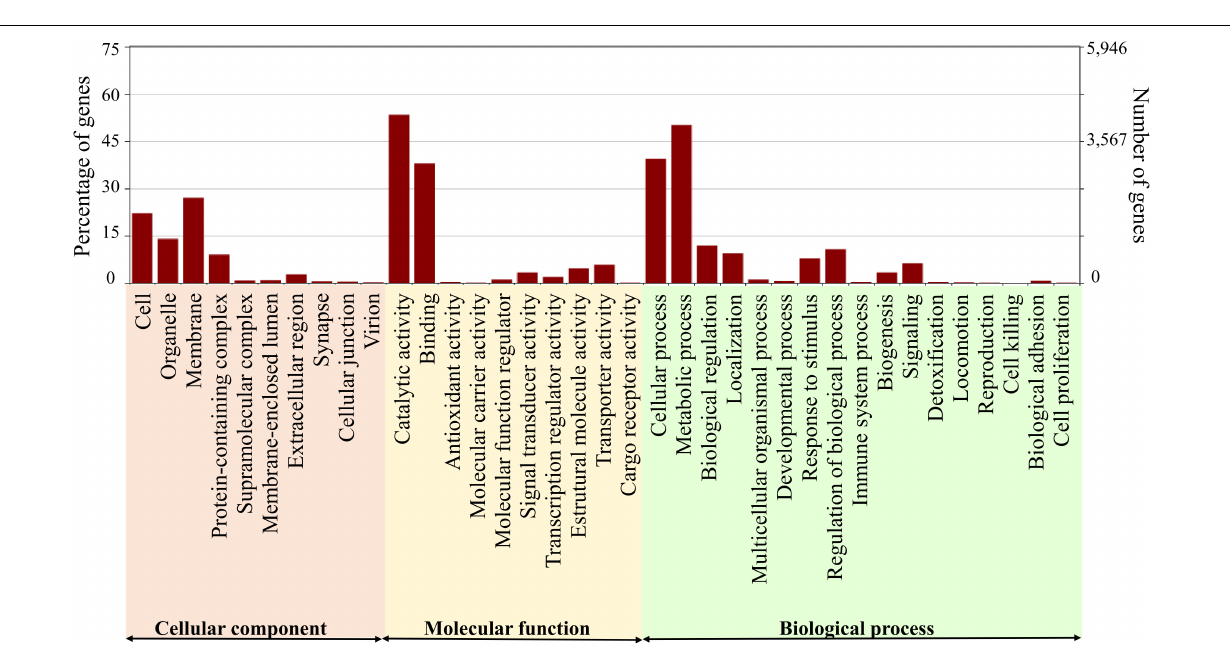
FIGURE 2 | Distribution of functionally annotated transcripts of Diatraea saccharalis in gene